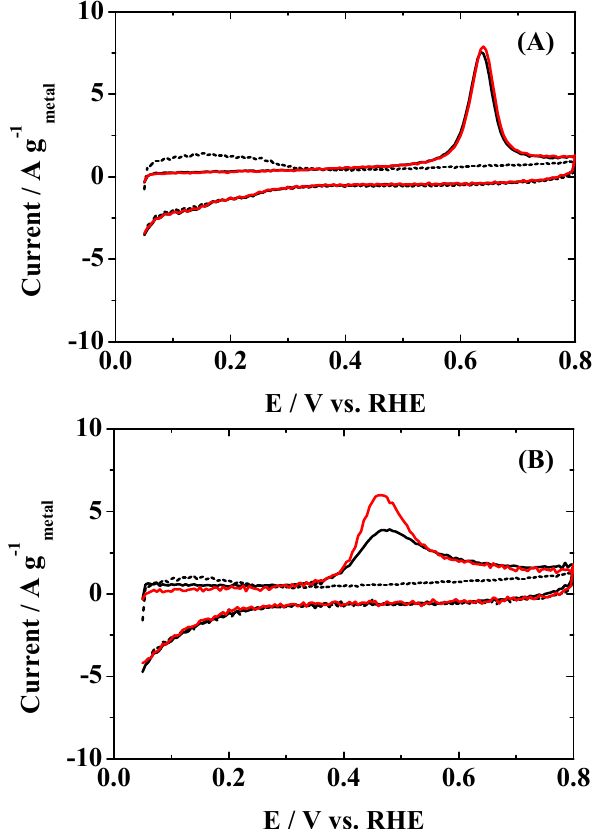
Figure 3. CO stripping voltammograms at Nafion ‐ coated ( A ) Pt 2AL –PtFe/C and ( B ) c ‐ Pt 2 Ru 3 /C electrodes measured in N 2 ‐ purged 0.1 M HClO 4 at 60 °C and potential sweep rate of 0.02 V ∙ s − 1 . Dotted lines indicate the blank CVs on the CO ‐ free electrodes. CVs were measured at 120 min in Figure 2 (red solid line) and 90 min in Figure 7 see below (black solid line).